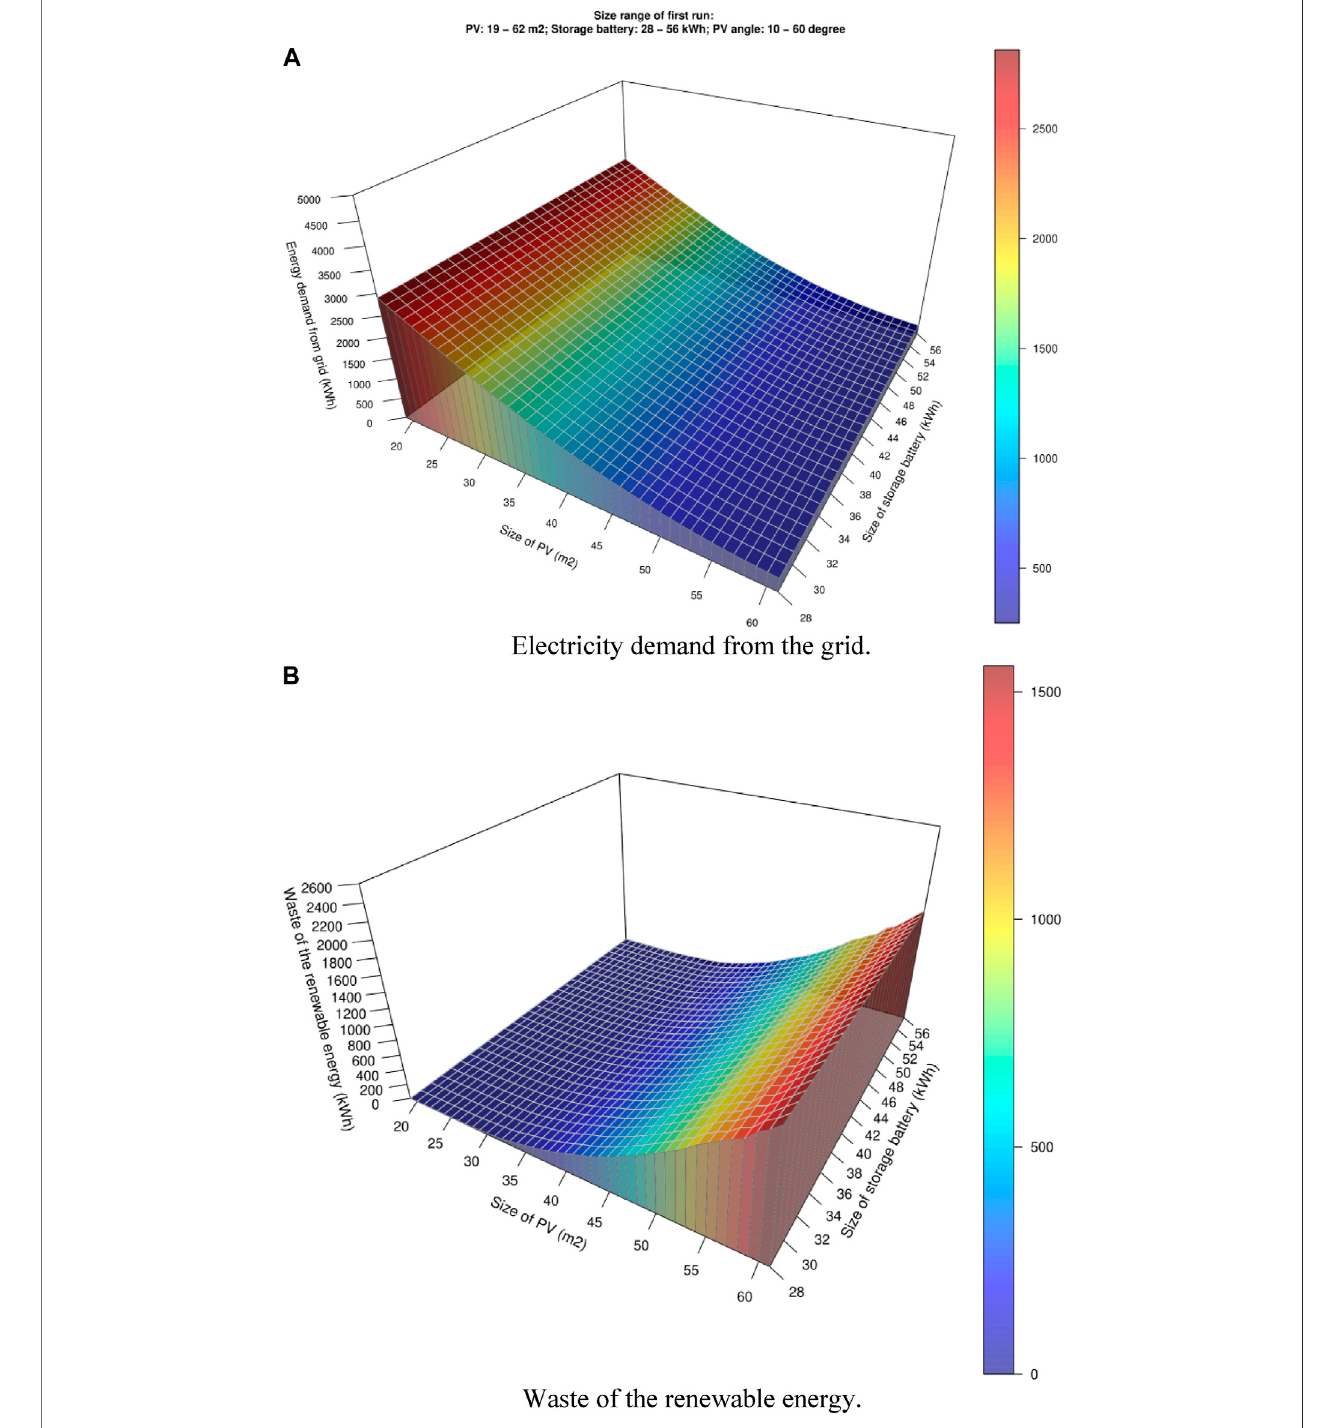
FIGURE 7 | Annual simulation results of the fi rst run: (A) electricity demand from the grid; (B) waste of the renewable energy; (C) electricity usage from the PV; (D) electricity usage from storage battery.